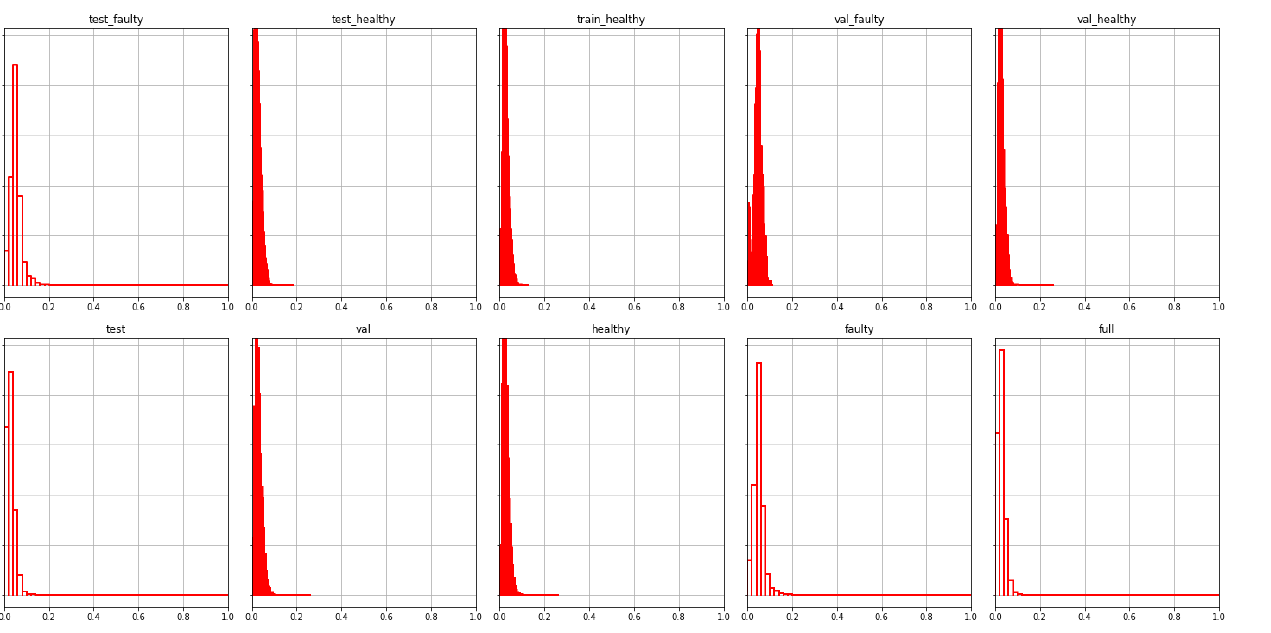
Figure 7. Anomaly score distribution with a LSTMAE obtained with a CAE